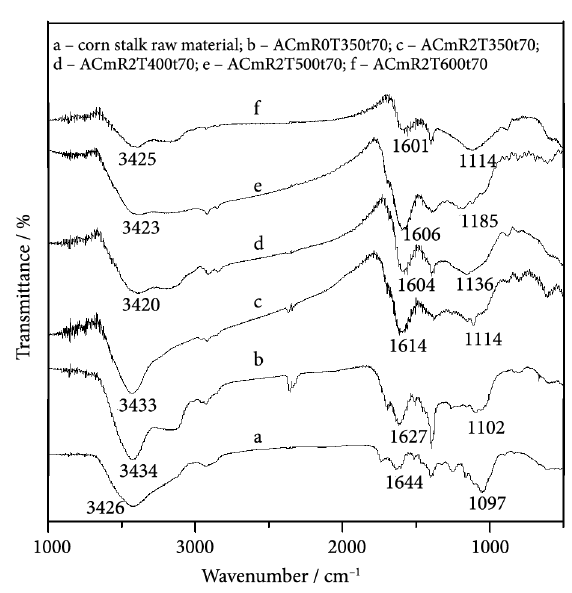
Figure 6. FT-IR curves of materials produced under different